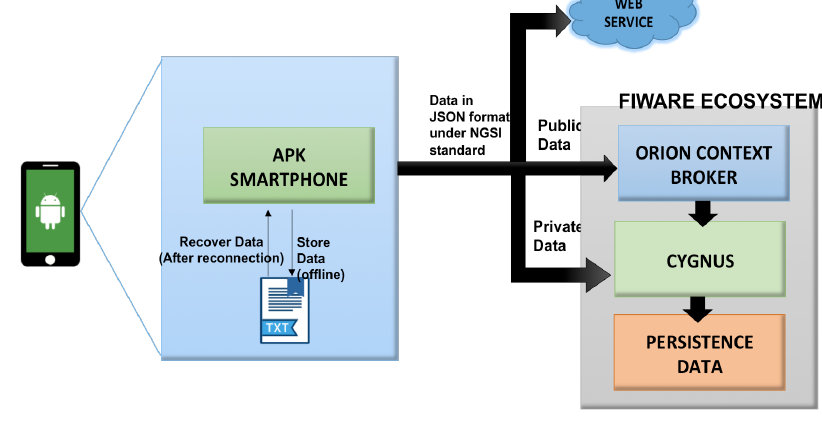
Figure 4 Proposed solution methodology